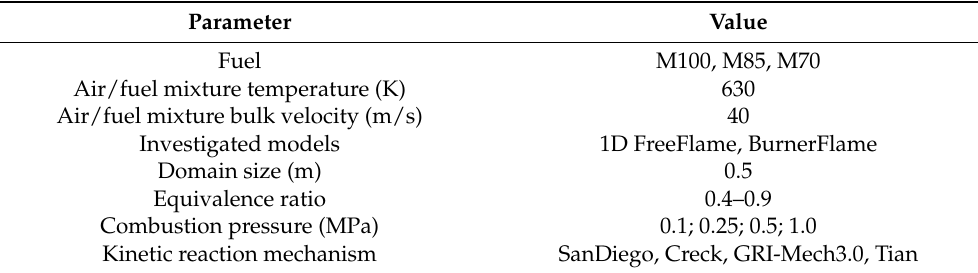
Table 4. Numerical setup